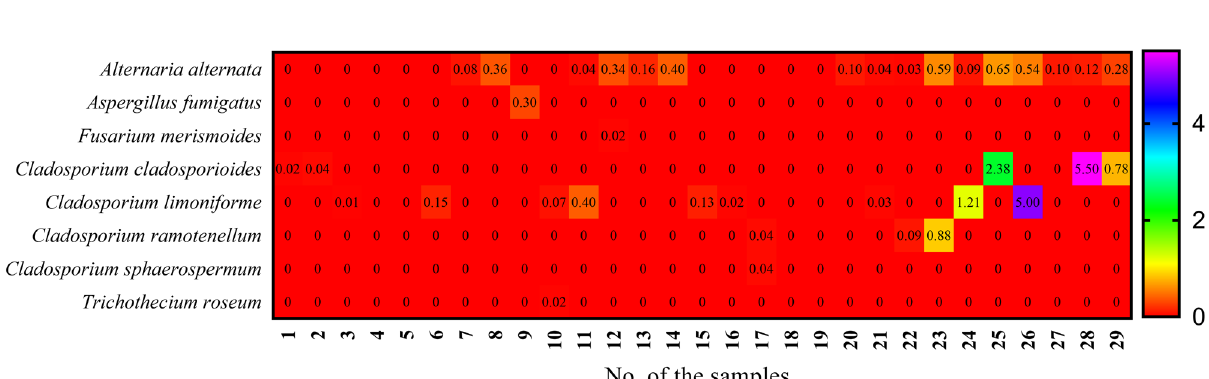
Figure 1. Fungal counts of species isolated from infected Vicia faba leaves and pods with baiting-plate method on DG18 medium at 28 °C for 7 days.